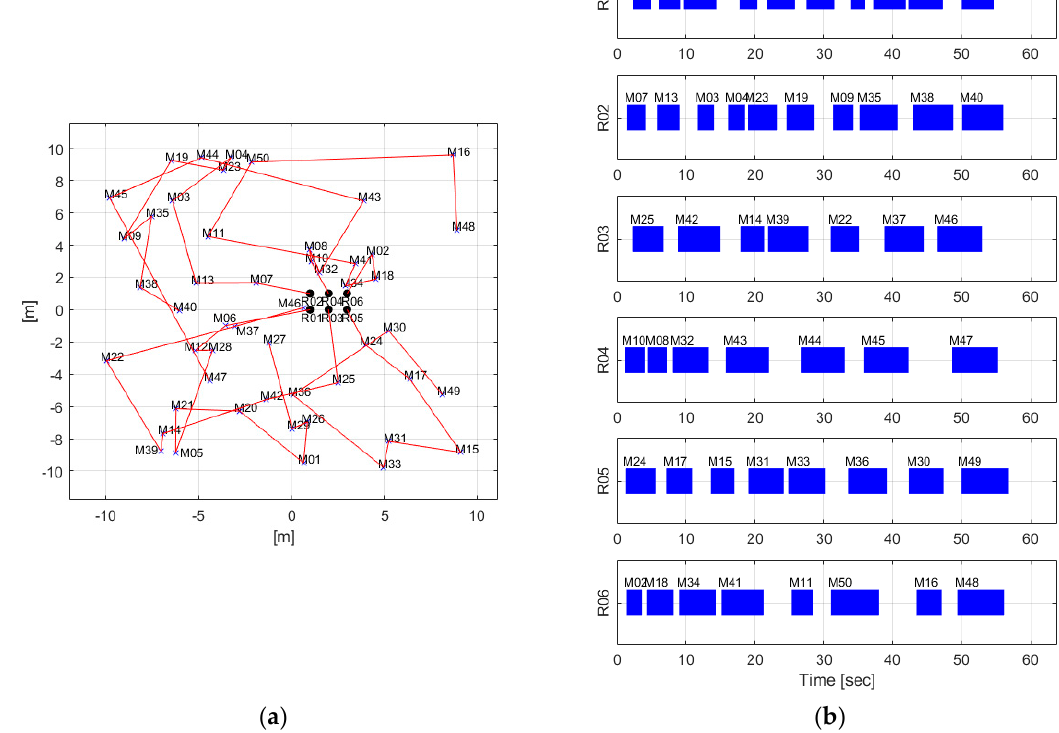
Figure 9. The results for huge case using proposed algorithm: ( a ) 2D situation map; ( b ) timetable.